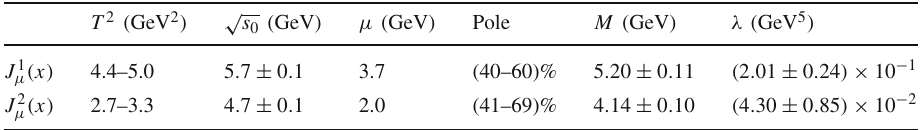
Table 3 The Borel